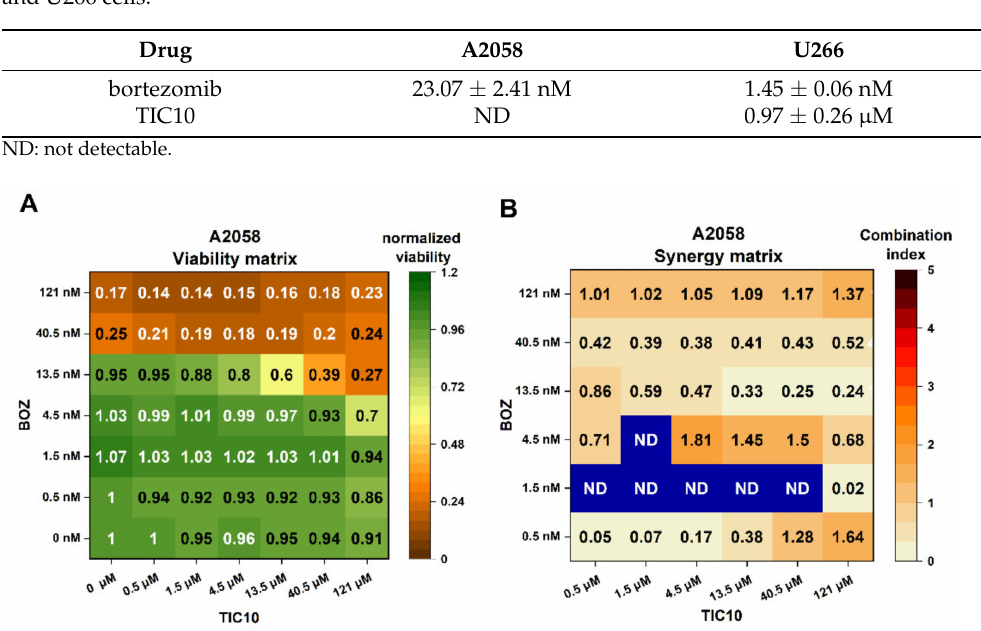
Figure 1. Heat maps showing antiproliferative effects of bortezomib (BOZ), TIC10 and their com- binations on A2058 cells after 72 h of incubation. ( A ) Normalized viability data are expressed as a ratio of medium control, and ( B ) combination index heat maps of various drug ratios. Combination index < 1, = 1 or > 1 represents synergism, additive effect or antagonism, respectively. ND: not detectable. Data are presented as mean values ( n =